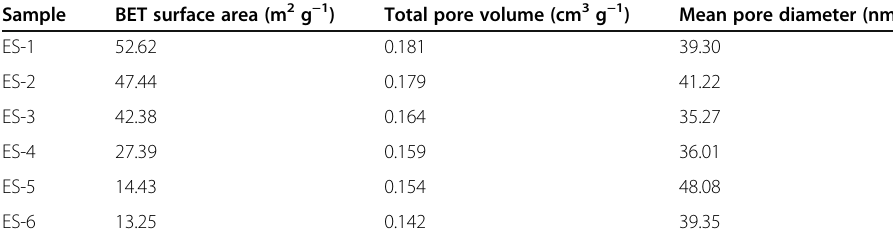
Table 3 Textural properties of bio-CaCO 3